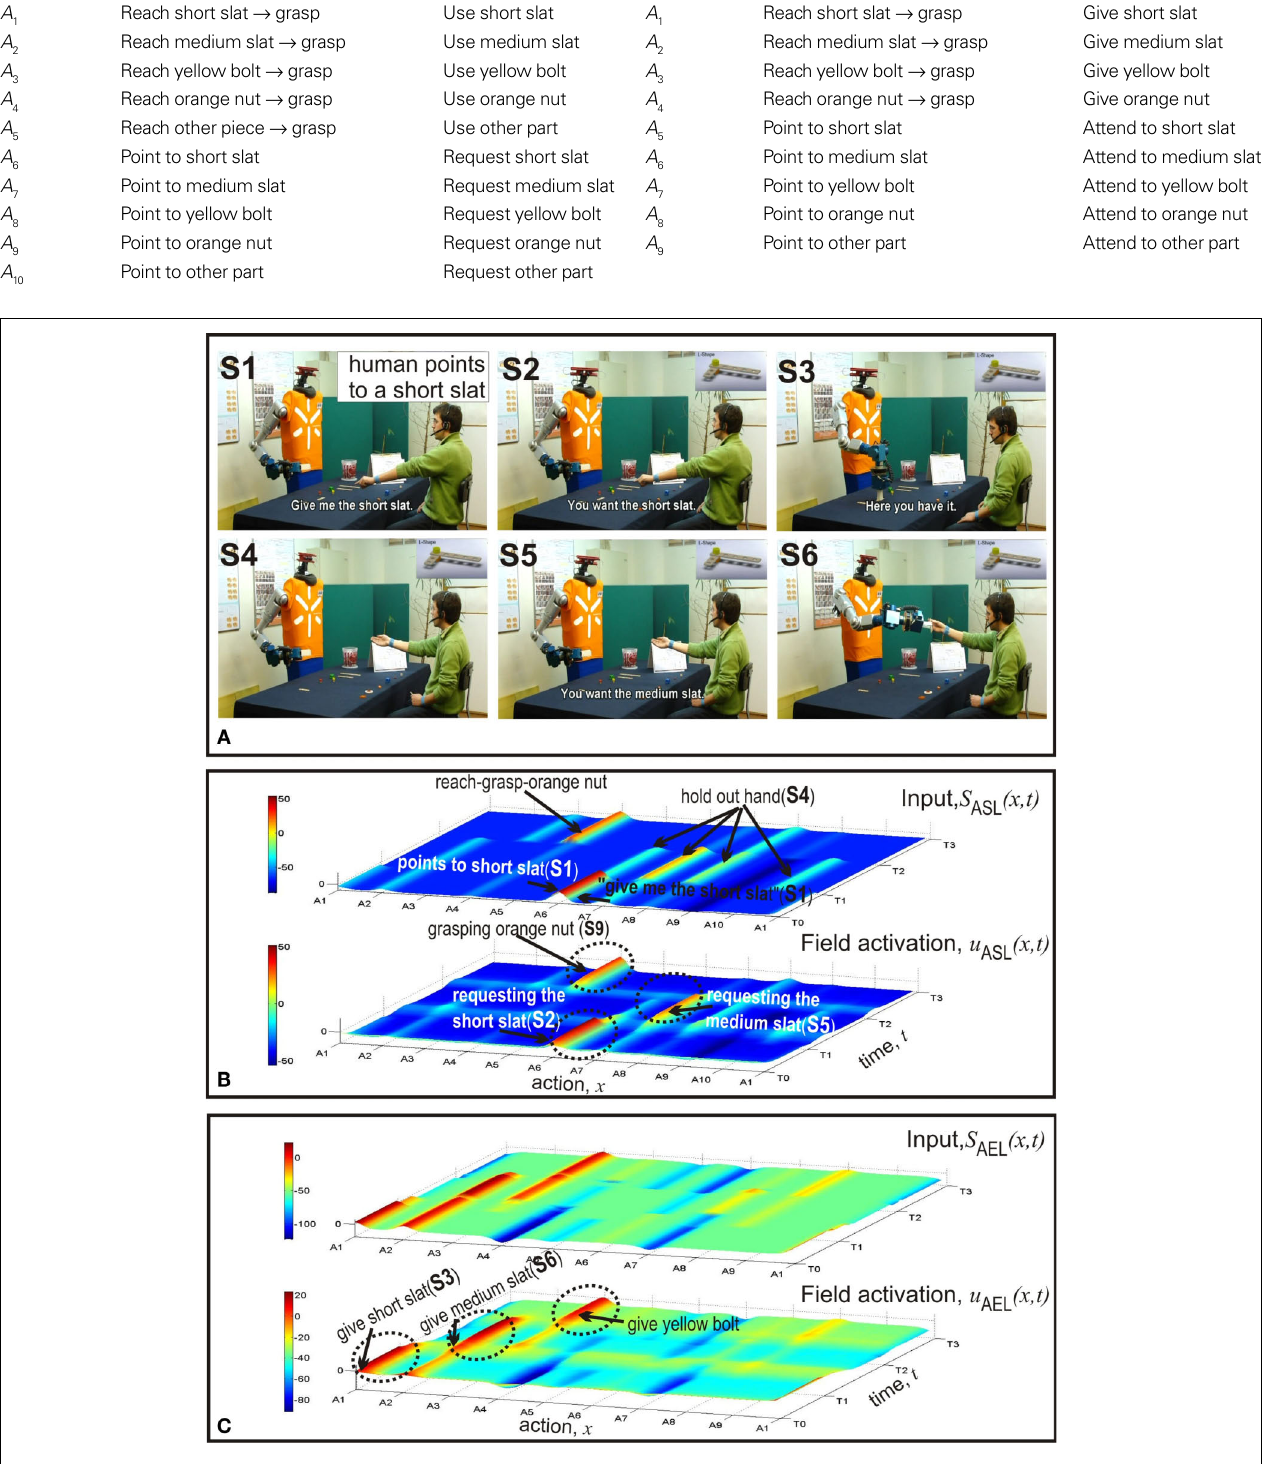
FIGURE 5 | Second example: faster goal inference and speeded decision making due to congruent information from gesture and speech. (A) Video snapshots. (B) Temporal evolutions of input to ASL (top) and activity in ASL (bottom). (C) Temporal evolutions of input to AEL (top) and activity in AEL